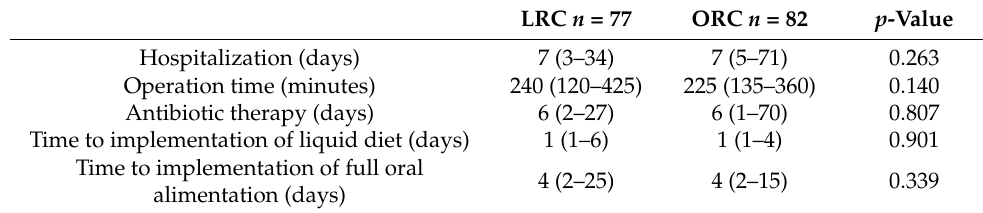
Table 4. Comparison of other parameters of LRC vs.